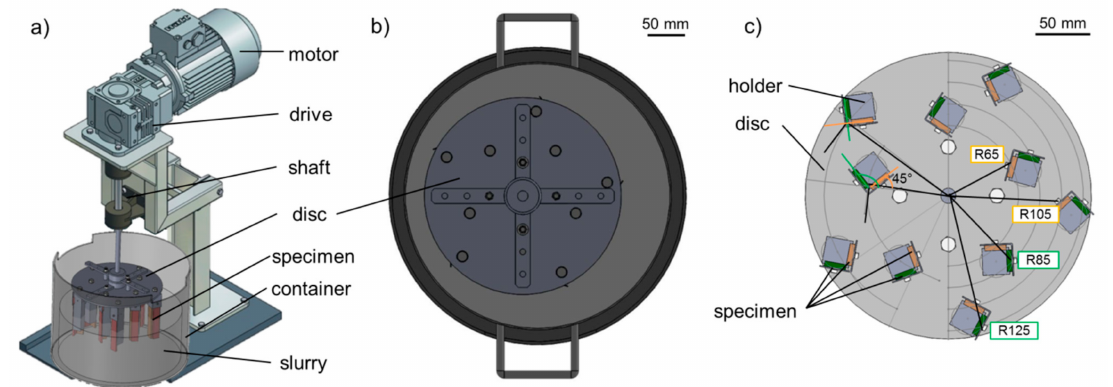
Figure 3. ( a ) Test rig concept [50]; ( b ) top view of the eccentric placed disc in pot; ( c ) bottom view of the disc with the mounted specimen on radii 65, 85, 105, 125 mm in different angle